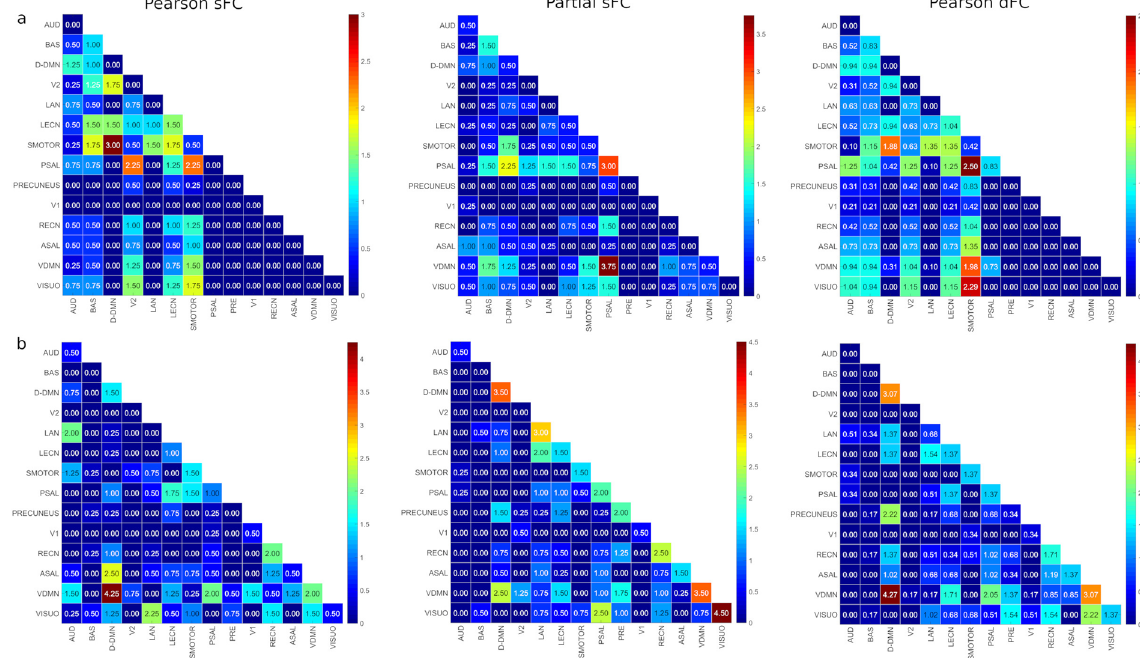
Figure 2. ( a ) Edge consistency percentages within and between RSNs for Pearson sFC, partial sFC and Pearson dFC methods at 5 percentile threshold. The color bar to the right of each figure displays the mapping of edge consistency percentage values to the color map. ( b ) Edge variability percentages within and between RSNs for Pearson sFC, partial sFC and Pearson dFC methods at 95 percentile threshold. The color bar to the right of each figure displays the mapping of edge variability percentage values to the color map. AUD-Auditory, BAS-Basal Ganglia, DDMN-Dorsal Default Mode Network, V2-Primary Visual, LAN-Language, LECN-Left Executive Control Network, SMOTOR- Sensorimotor, PSAL-Posterior Salience, PRE-Precuneus, V1-High Visual, RECN-Right Executive Control Network, ASAL-Anterior Salience, VDMN-Ventral Default Mode Network,